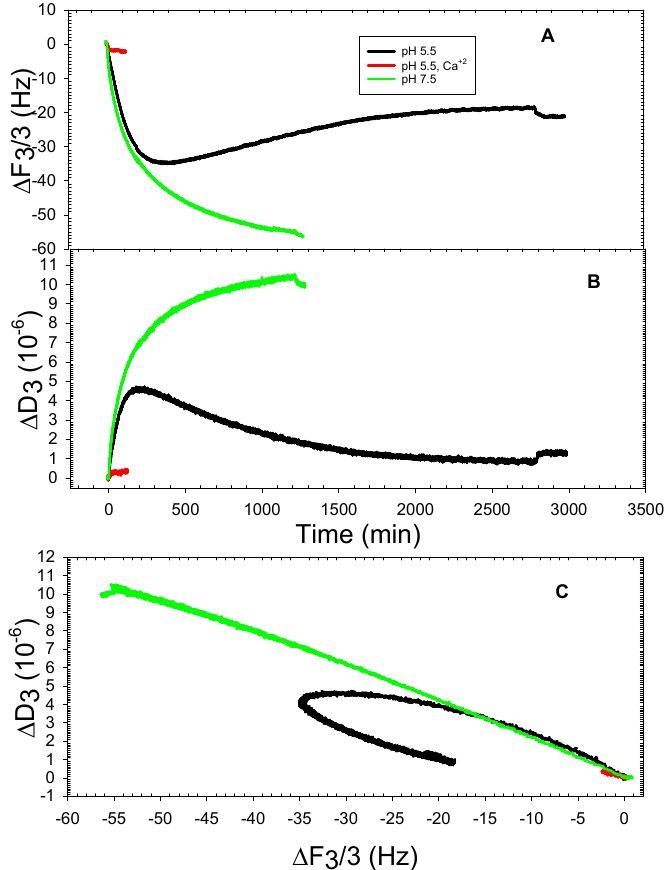
Figure 5. Representative QCMD frequency ( A ) and dissipation ( B ) shifts of DOPPE adsorption onto silica at pH 5.5 and pH 7.5 in the absence and presence of 2 mM CaCl 2 ; ΔF vs. ΔD plot ( C ).